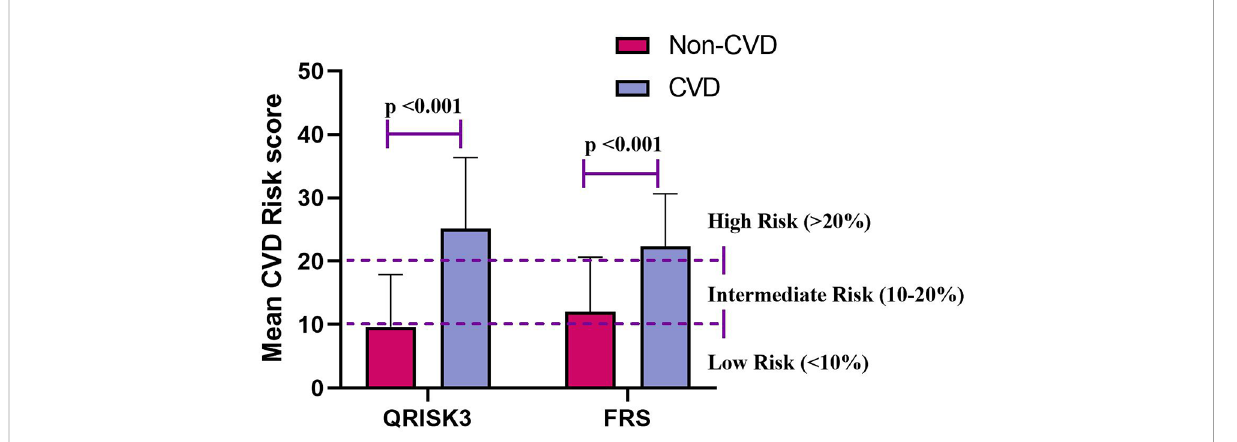
FIGURE 3 Mean CVD risk score for QRISK3 and FRS. Legend: Strati fi ed according to patients with CVD (n=138) and patients without CVD (n=428). CVD, cardiovascular disease; QRISK3, QRESEARCH risk estimator version 3; FRS, Framingham risk score.